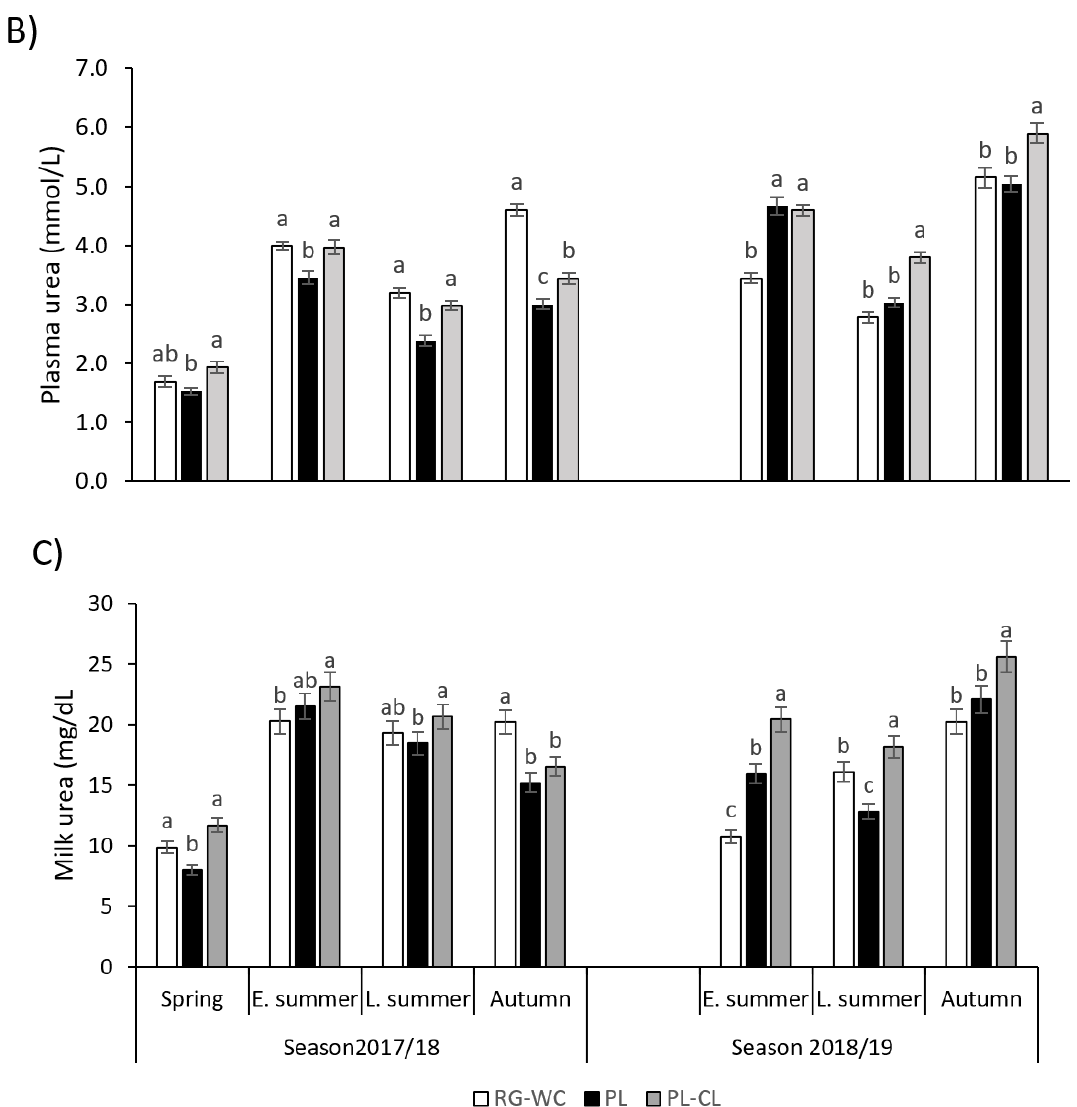
Figure 2. Urea concentration in ( A ) urine, ( B ) plasma and ( C ) milk of cows grazing plantain (black), plantain–clover (grey), and ryegrass–white clover (white) pastures in spring, summer (early and late), and autumn during the 2017/2018 (left) and 2018/2019 (right) lactating seasons. a,b,c letters indicate values in each season that are significantly different ( p < 0.05).